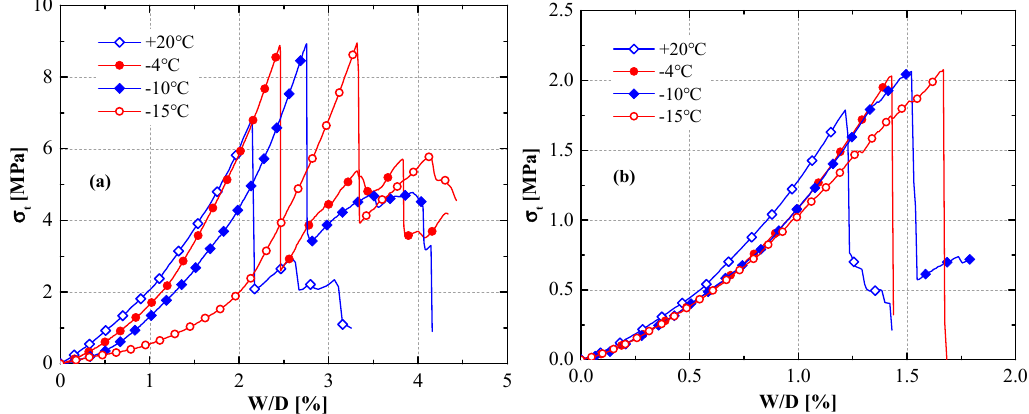
Figure 1. Stress–strain curves in indirect tensile tests under different temperatures: ( a ) sandstone, ( b ) coal samples.